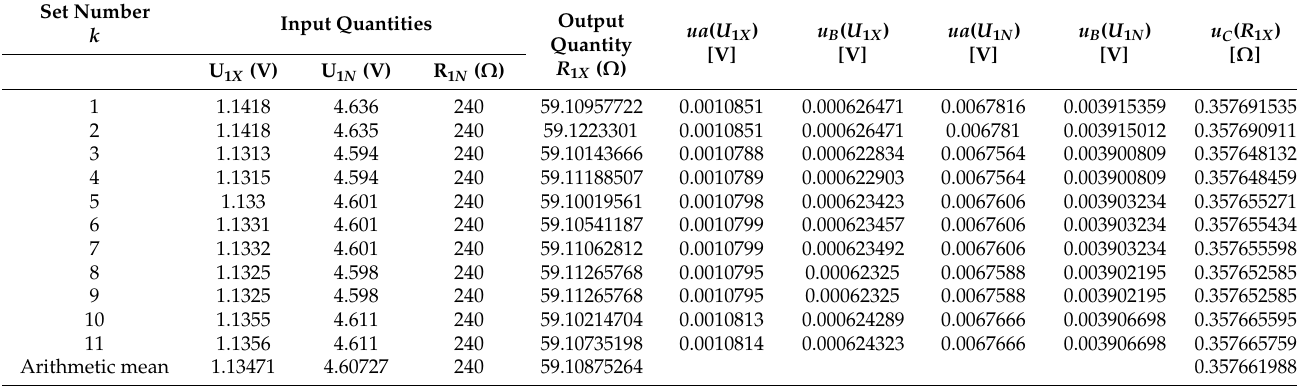
Table 4. Value of the output quantity R X and the associated combined uncertainty u C that was obtained according to the 2nd approach from eleven sets of simultaneous